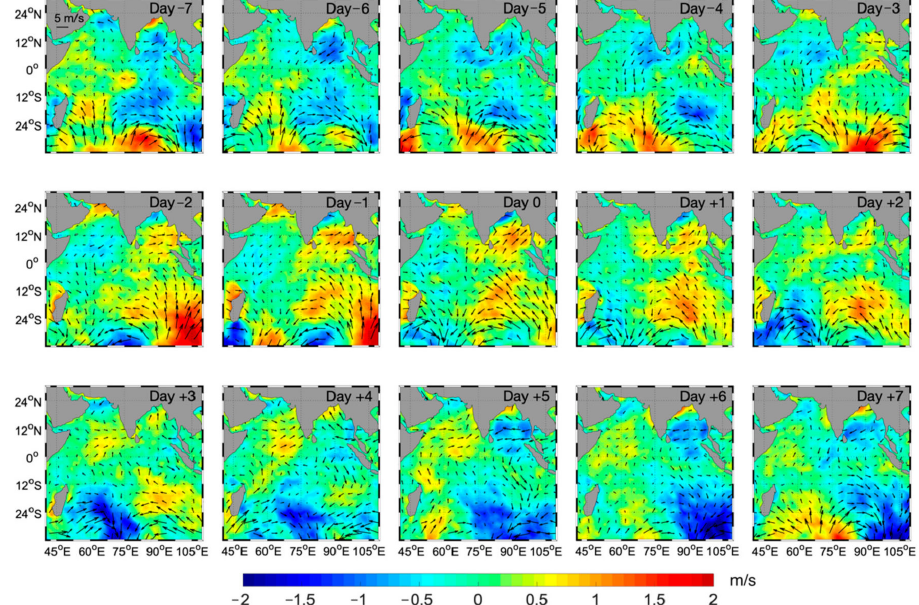
Figure 5. Time-lag composites of surface wind magnitude (shaded; m/s) in the Indian Ocean based on a 10–20-day bandpass-filtered time series in the southeastern Indian Ocean, overlaid with surface wind